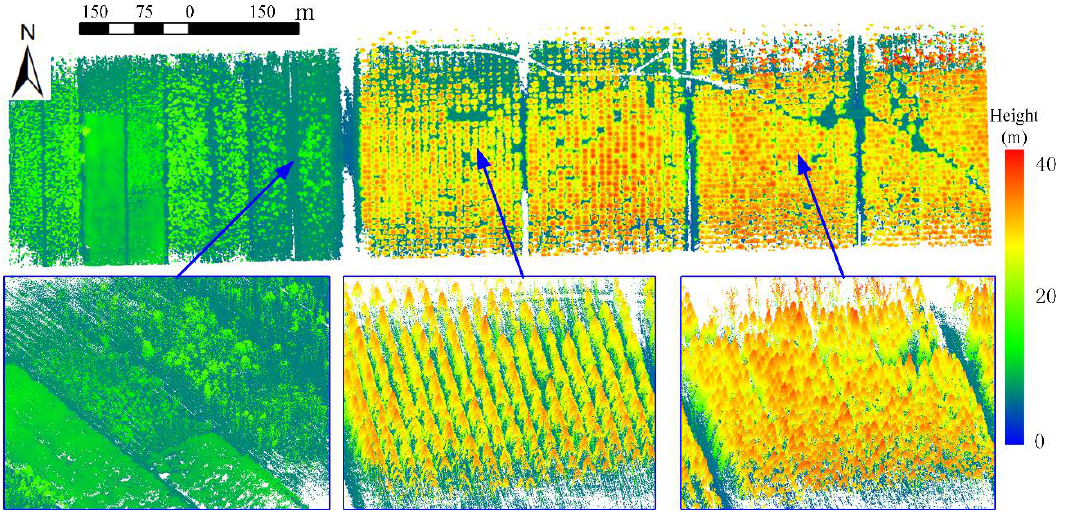
Figure 7. Reconstruction of the optimized point